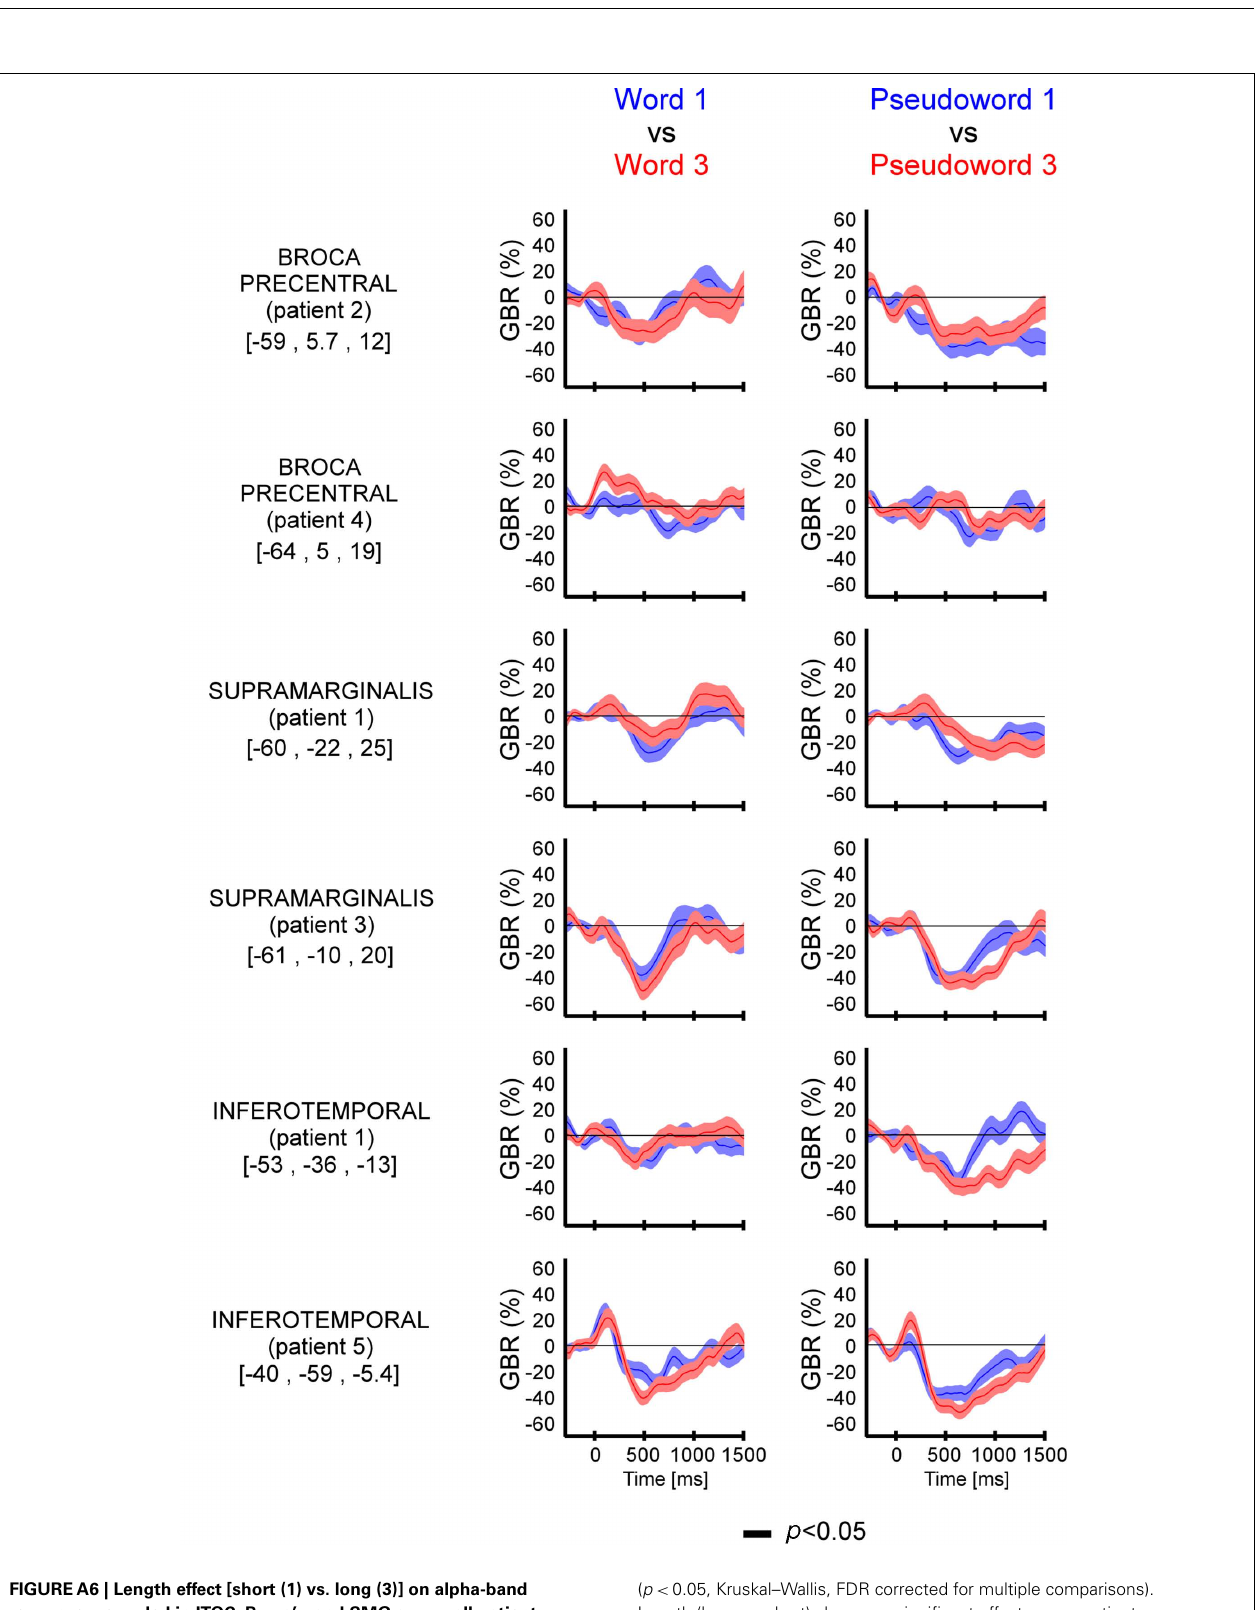
( p < 0.05, Kruskal–Wallis, FDR corrected for multiple comparisons). Length (long vs. short) shows no significant effect across patients and recording sites. For each region theTalairach coordinates are